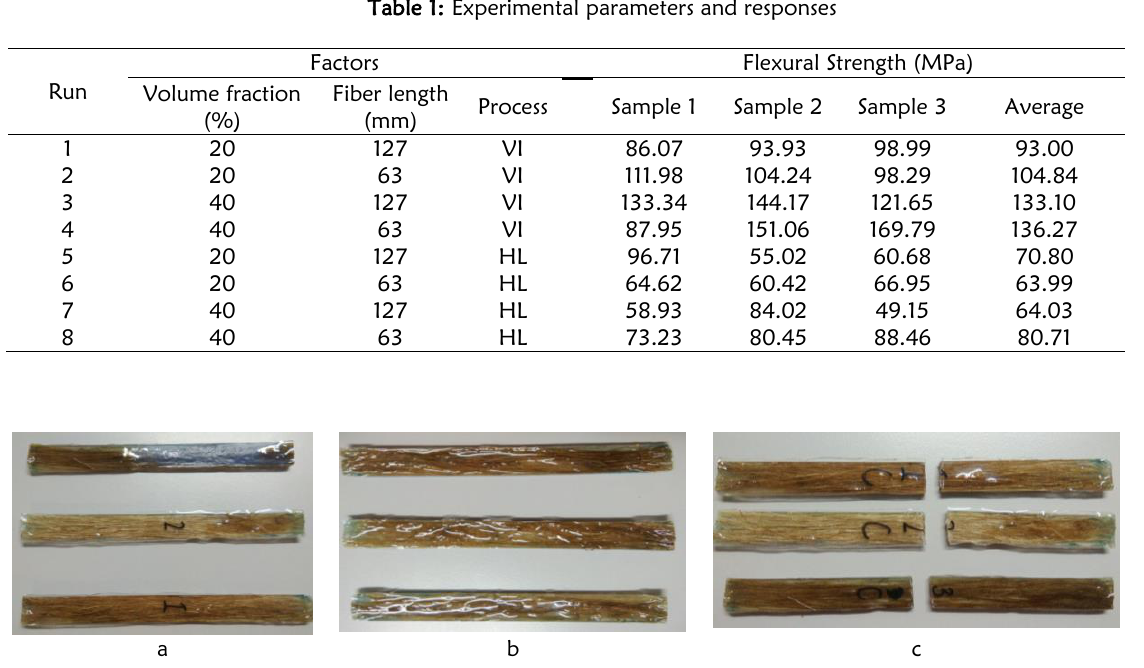
Figure 2: Specimens of banana fiber-epoxy composites; (a) produced by vacuum infusion process, (b) produced by hand layup process, and (c) after undergoing flexural test.